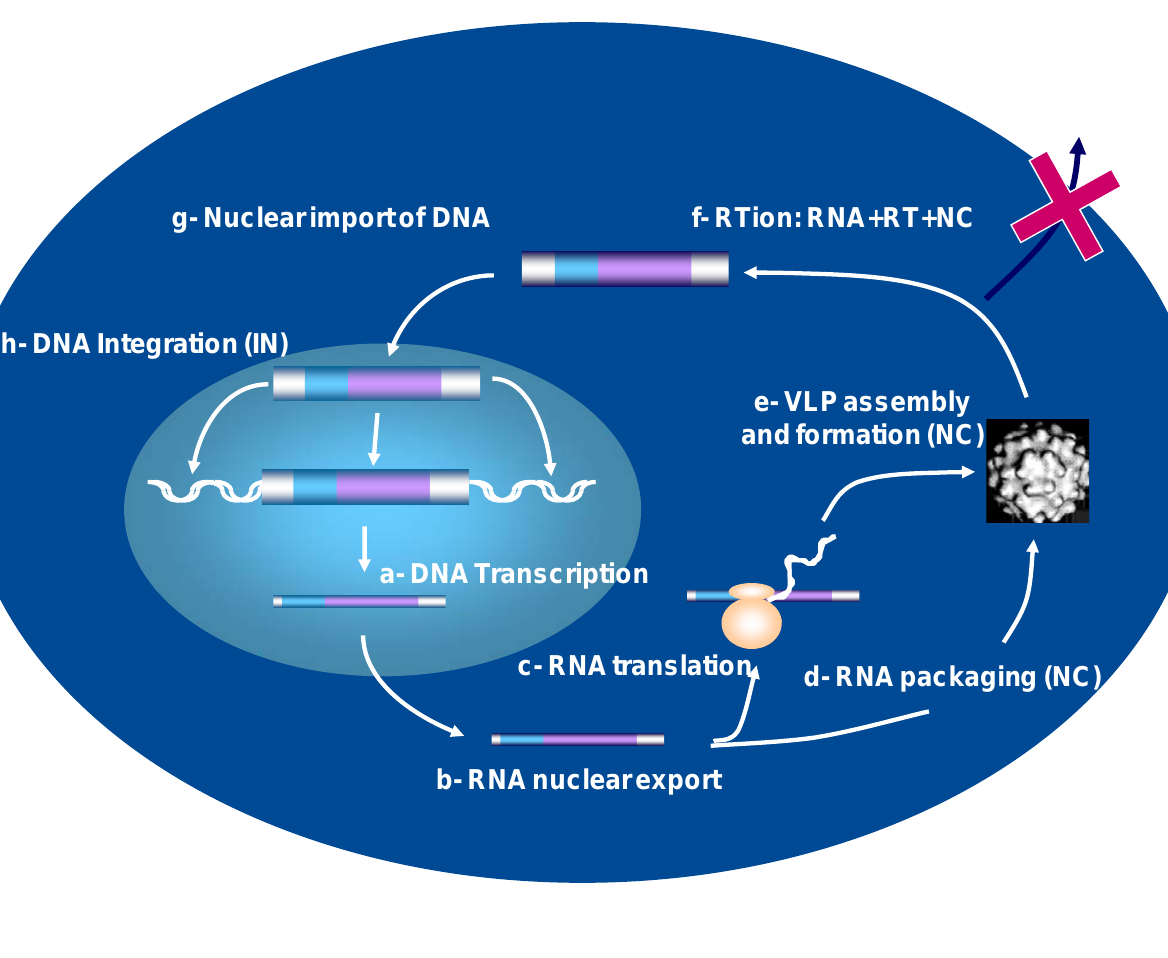
Figure 1. Schematic representation of the replication of a simple retrotransposon. a. The genomic RNA is a unique RNA synthesized by transcription of the integrated retrotransposon DNA. b.-c. The RNA copy is exported from the nucleus and translated by the cellular translation machinery – ribosomes are illustrated here - to produce the Gag and GagPol like polyprotein precursors. d.-e. During formation of a ribonucleoparticle (RNP) called VLP (virus-like particle or VLP) the Gag and GagPol precursors undergo maturation by a Pol-encoded protease. At the same time the RNA copy of the retrotransposon, together with the replication primer tRNA are incorporated into the VLP. Note that the VLP’s remain in the cytoplasm and are not exported (cross) contrary to replication-competent retroviruses. f. Reverse transcription of the RNA copy is carried out by the RT and is chaperoned by NC-like proteins in the VLP nucleoprotein structure to generate a new copy of retrotransposon DNA. g.-h. The new DNA copy is imported into the nucleus and integrated into the host cell genome by the Pol-encoded integrase to complete the copy- and-paste